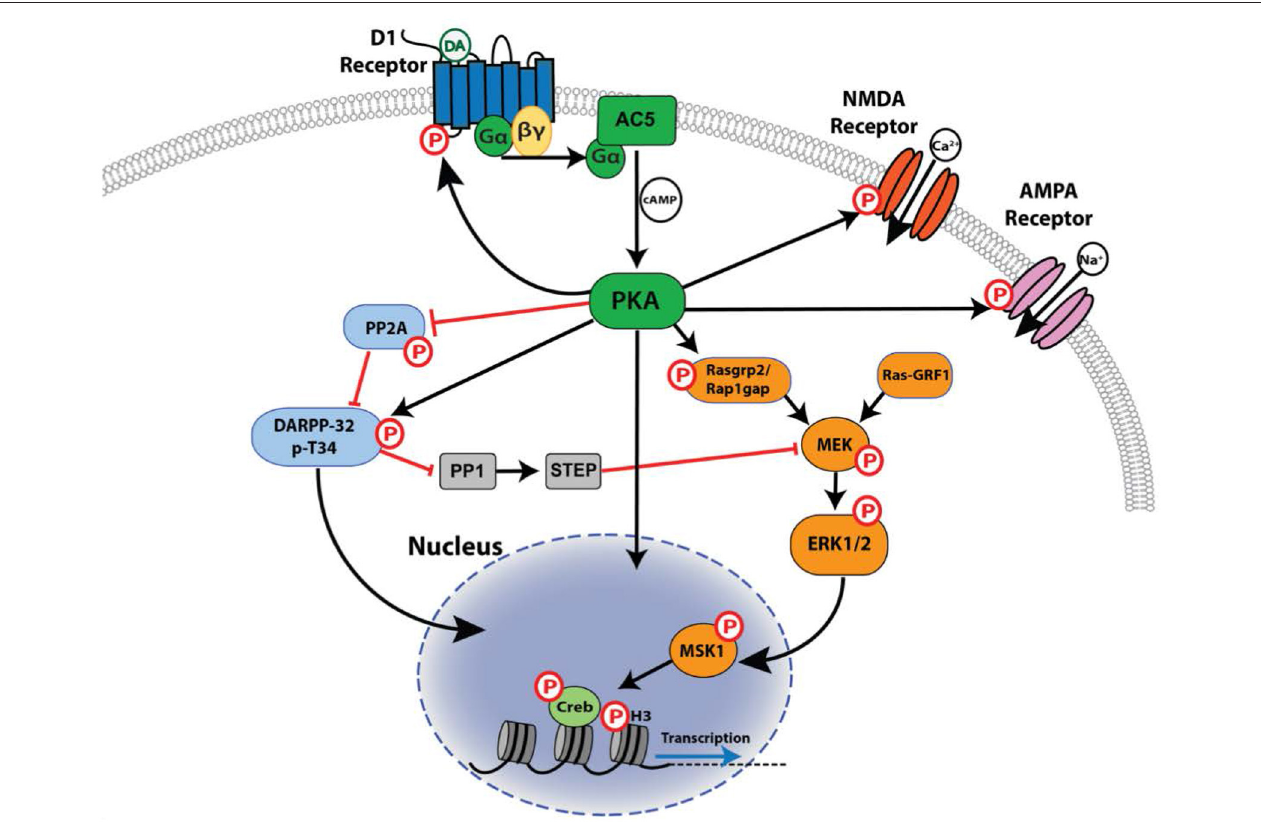
FIGURE 3 | Signaling downstream of the D1R. Shown is the network of core signaling pathway interactions downstream of D1R activation in striatal neurons, with a focus on phosphorylation-dependent (P) actions mediated by PKA. Activation is indicated by a black arrowed line, inhibition by a red